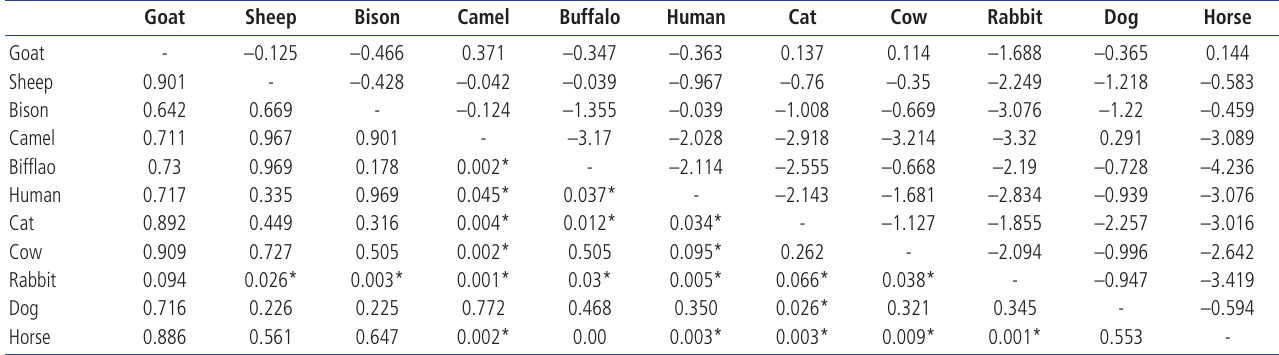
Table 5. Codon-based test of neutrality for analysis among species Goat